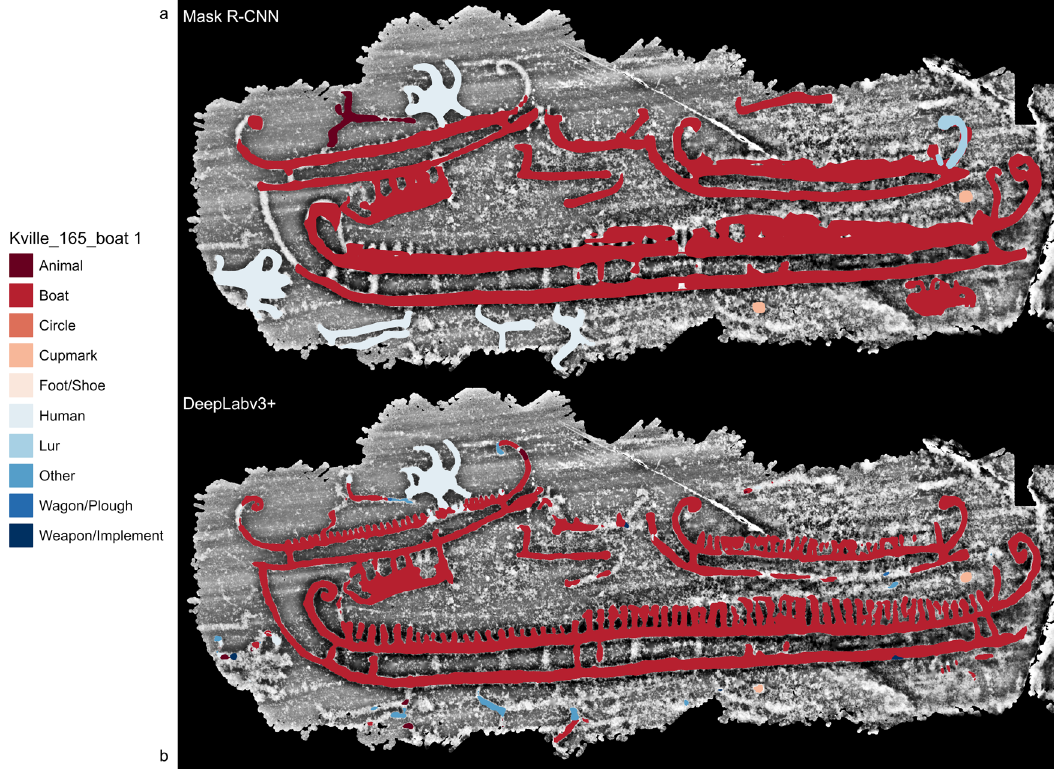
Figure 2: Examples of segmentations created by: ( a ) DeepLabv3 + with ResNet - 50 backbone ( pixel - based classi fi cation ) and ( b ) Mask R - CNN with ResNet - 50 backbone ( object - based classi fi cation ) . Classi fi ed image visualization of 3D model ( Horn et al. 2019, 2022 ) . Documentation by Henrik Zedig ( County Administrative Board in West Sweden )